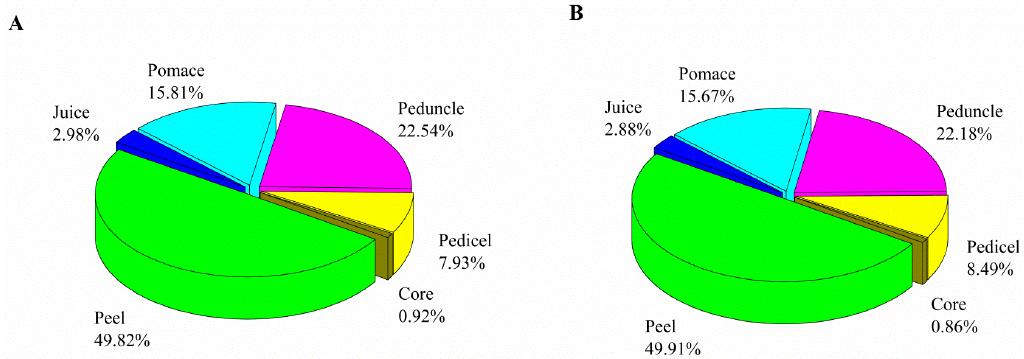
Figure 4. Distributions of cyflumetofen in apple samples, ( A ) (−)-cyflumetofen; ( B ) (+)-cyflumetofen.